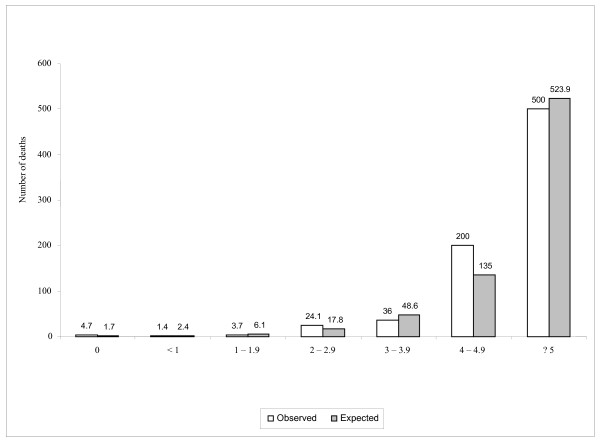
Observed and Expected number of deaths per 1000 in each score category.